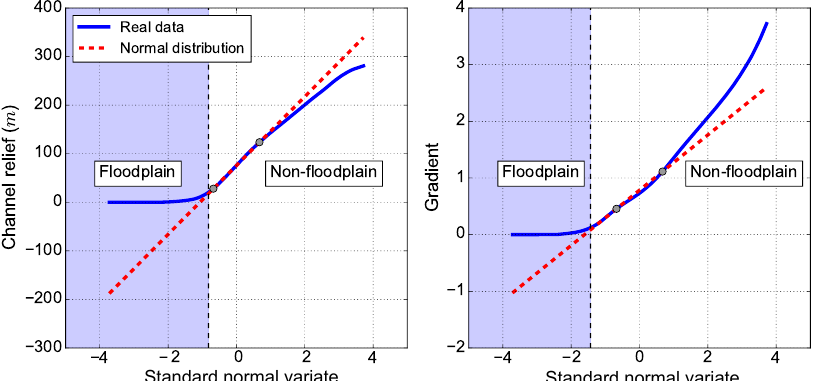
Figure 2. Example quantile–quantile plots for Mid Bailey Run, Ohio, showing probability density function of relief relative to the channel and slope. The probability density function of each is shown in blue, with the reference normal distribution shown by the red dashed line. The threshold (black dashed line) is selected where there is less than 1% difference between the real and reference distributions. The blue box highlights the portion of the distribution identified as floodplain.